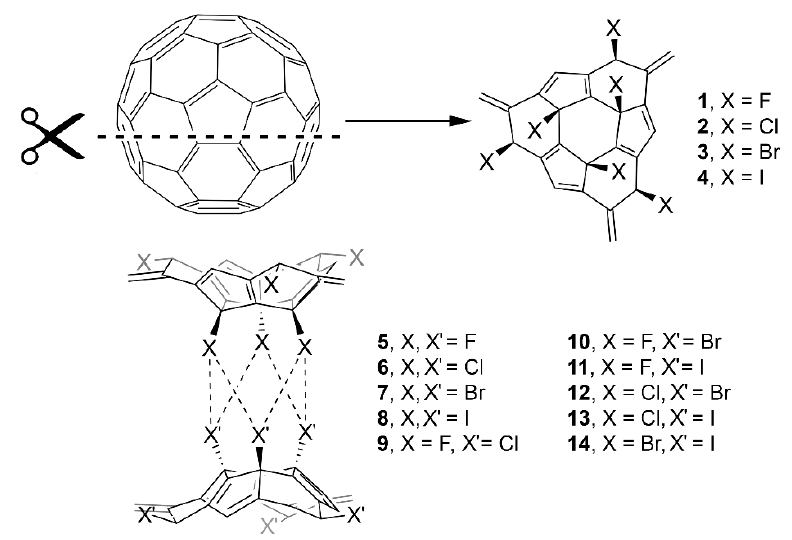
Figure 1. Compounds and complexes 1 – 14 studied in this work.